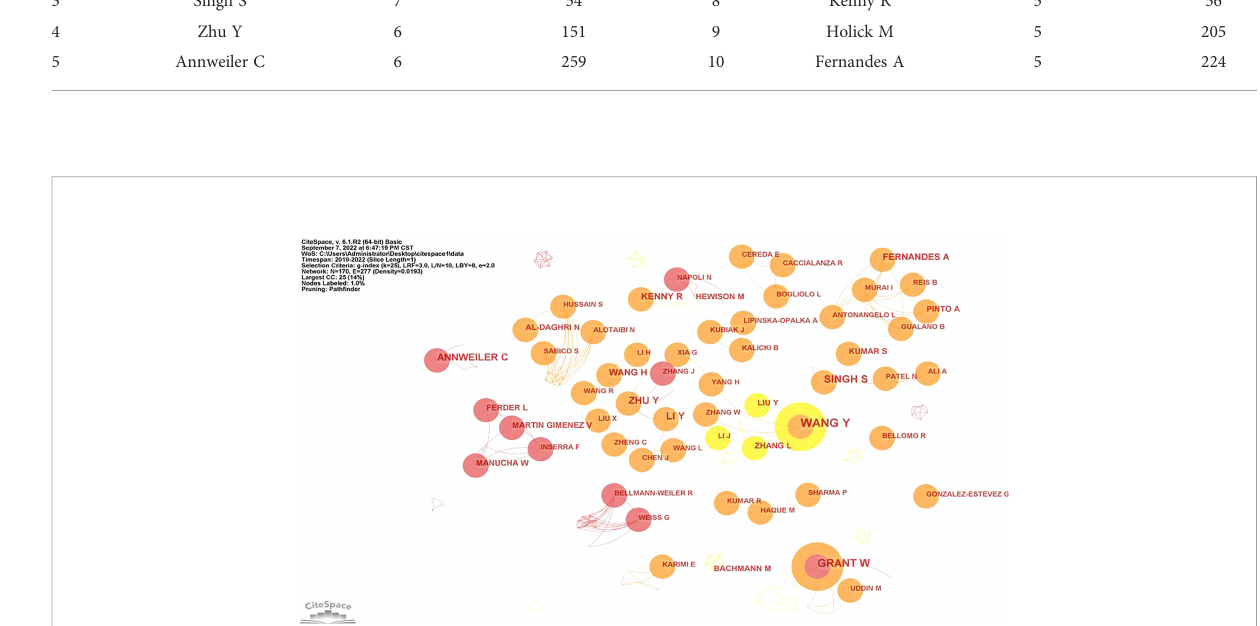
FIGURE 3 Network map showing authors ’ collaborations in COVID-19 and Dietary Supplements